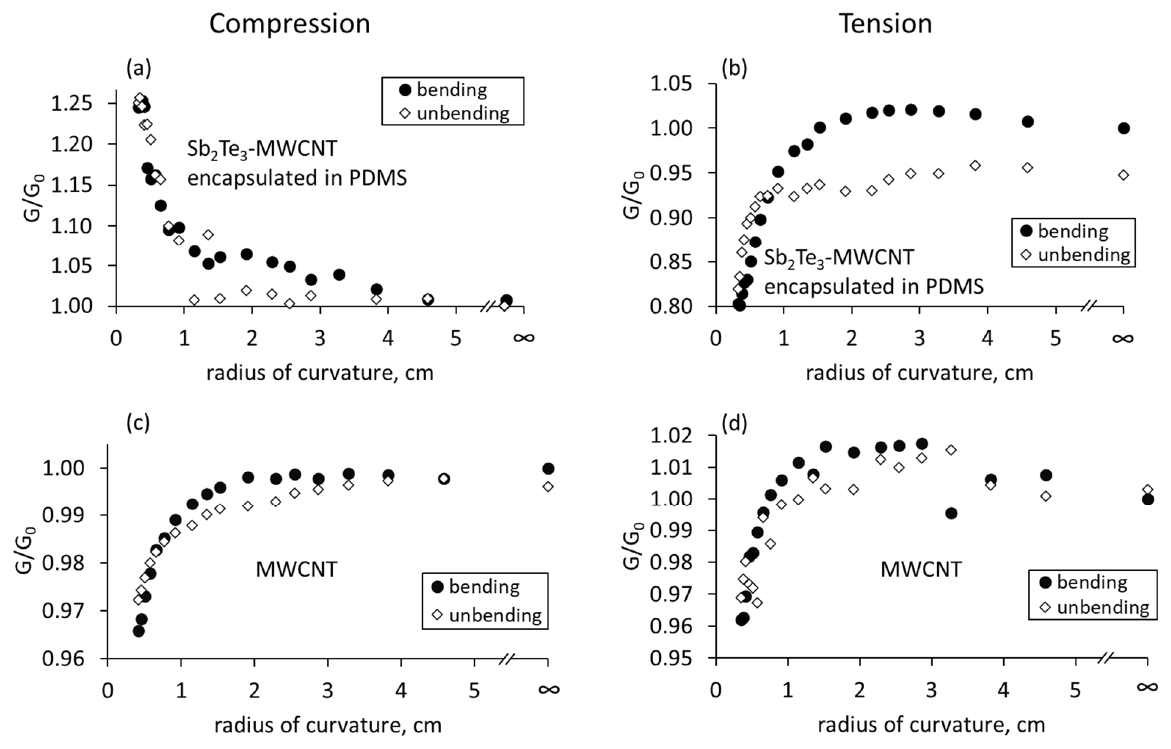
Figure 5. Relative changes in conductance of Sb 2 Te 3 -MWCNT heterostructures and bare MWCNT networks encapsulated in PDMS vs. its radius of curvature, while the side with higher Sb 2 Te 3 concentration is subjected to compression ( a , c ) or tension ( b , d ). G is the conductance of the bent flexible film, G 0 is the conductance of the not bent flexible fi lm.